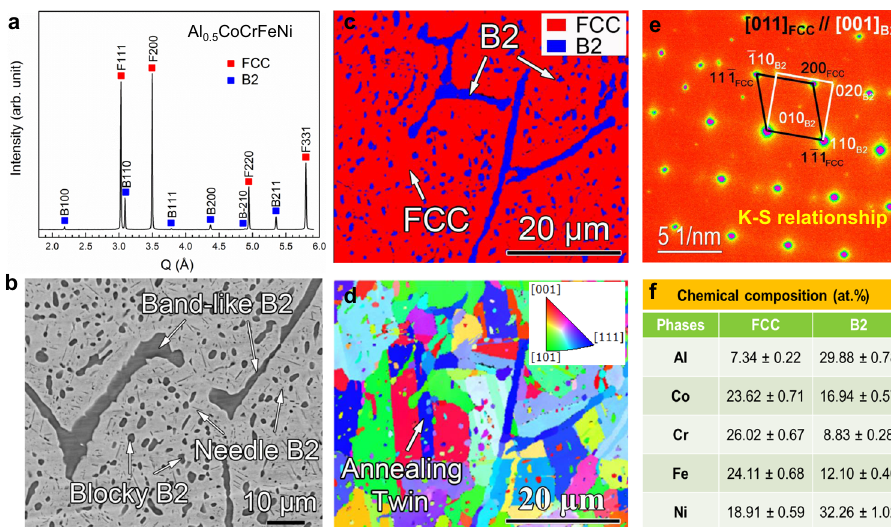
Fig. 1 Phase and microstructural information of the studied HEA. a HEXRD of the Al 0.5 CoCrFeNi alloy, showing the presence of FCC and B2 phases (the diffraction peaks of FCC and B2 phases are indexed as F-hkl and B-hkl, respectively). b Back-scattering electron (BSE) image of the studied alloy, presenting the three different morphologies of the B2 phase. c , d EBSD-phase map and corresponding grain-orientation image, respectively. e SAED patterns of FCC and B2 phases along FCC ’ s [011] and B2 ’ s [001] directions, indicating the K – S crystallographic relationship between the FCC matrix and the B2 precipitates.